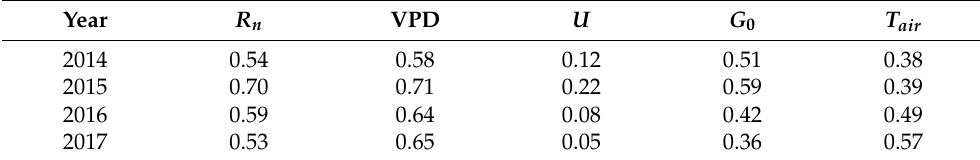
Table 7. R 2 of the univariate regressions of actual evapotranspiration against each considered driver in each growing season. (All regressions are significant at 95% confidence